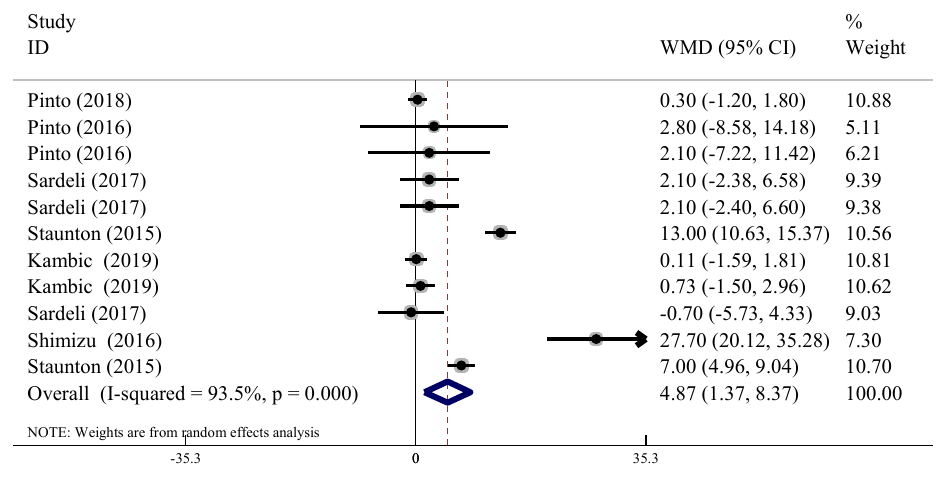
Figure 5. Forest plot of the acute effect of LL-BFR training on DBP.